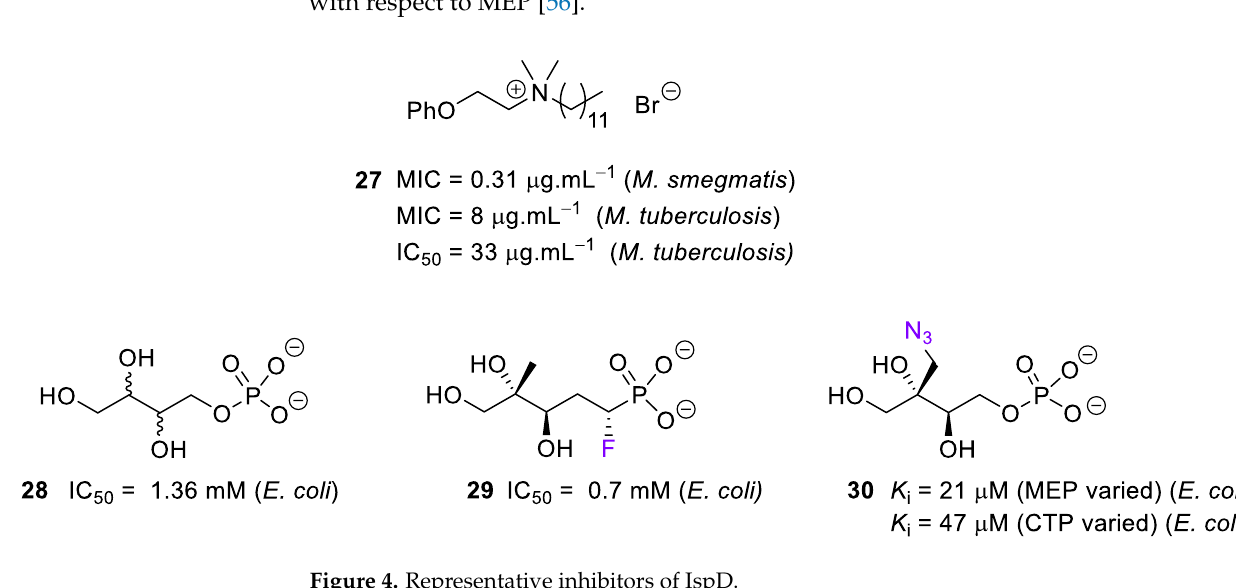
Figure 4. Representative inhibitors of